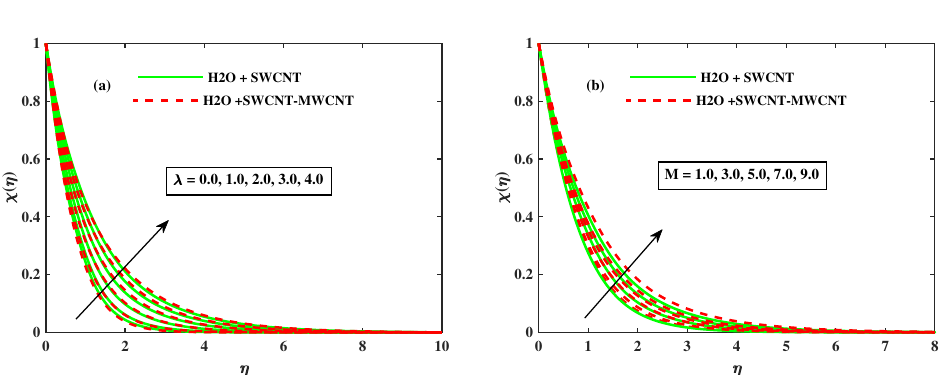
Figure 7. Effect of Nb and Nt on Φ ( η ) .